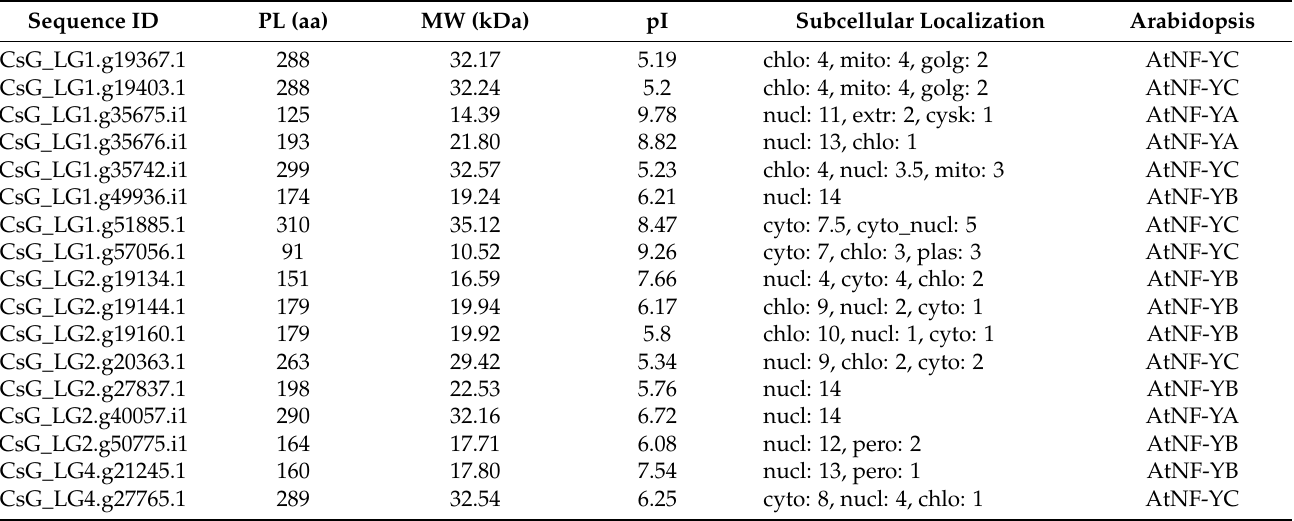
Table 1. Properties of the predicted NF-Y genes in C. seticuspe